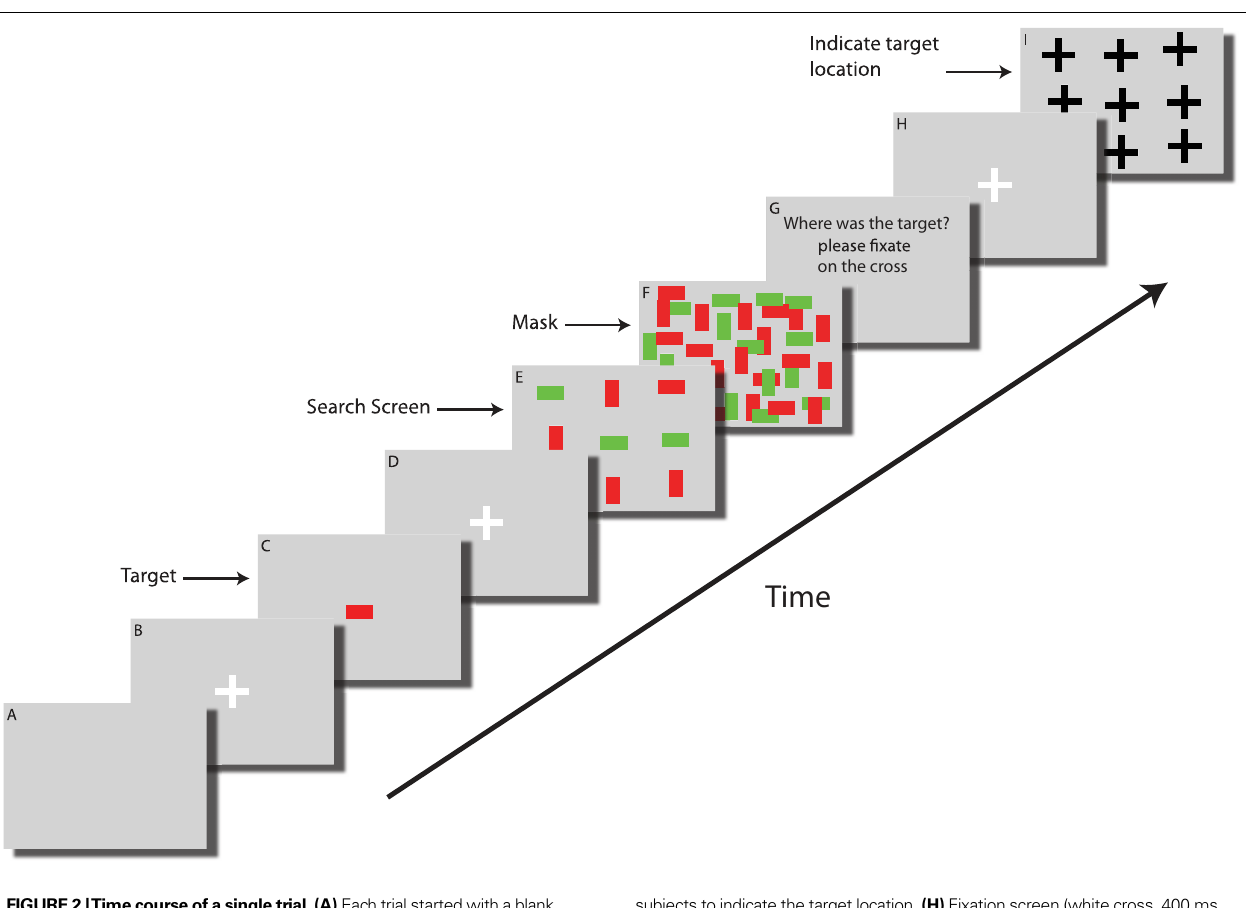
FIGURE 2 | Time course of a single trial. (A) Each trial started with a blank screen (background color gray) and was shown for 1 s. (B) Fixation screen (white cross, 400 ms, fi xation enforced). (C) The target (here a red horizontal bar) was shown at the center of the screen for 1 s. (D) A fi xation screen (white cross, 400 ms) was shown to assure that subjects always started the search at the center of the screen (fi xation enforced). (E) The search screen consisted of 49 items and was shown for a random amount of time ( < 25 s), suffi cient for subjects to fi nd the target in about 50% of all trials. (F) Immediately after search screen offset the mask was shown for 100 ms. (G) An instruction screen (1 s) reminded